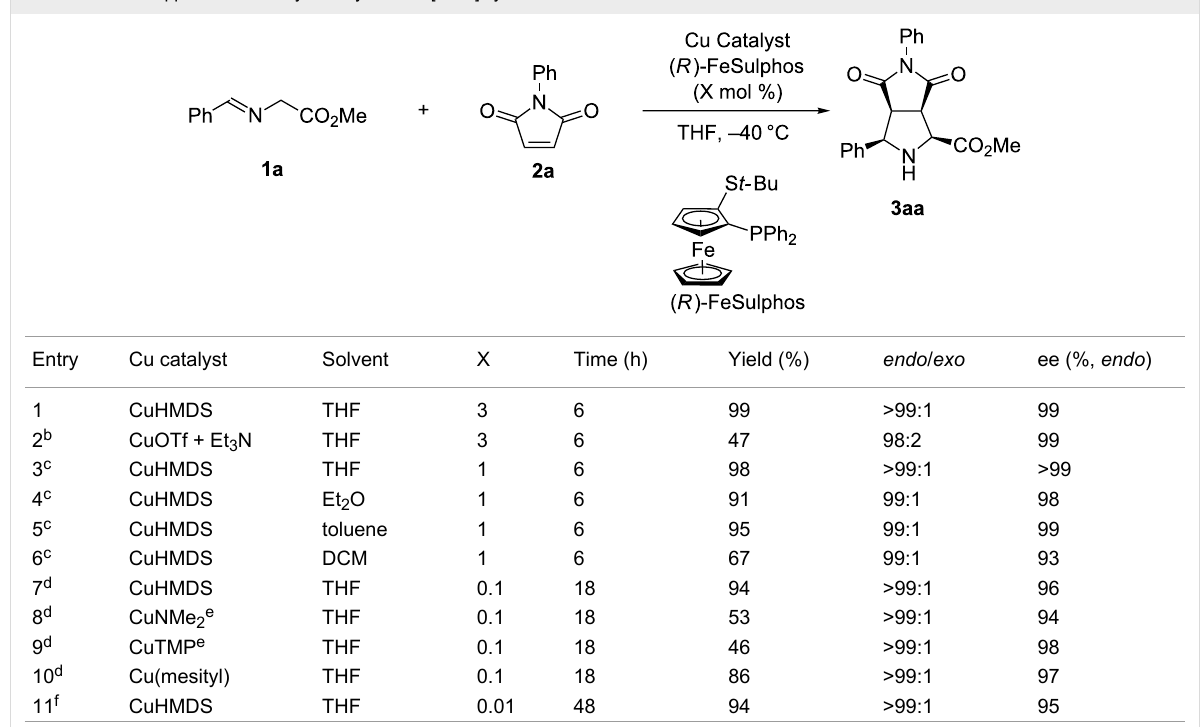
Table 1: Chiral copper amide-catalyzed asymmetric [3 + 2] cycloadditions a